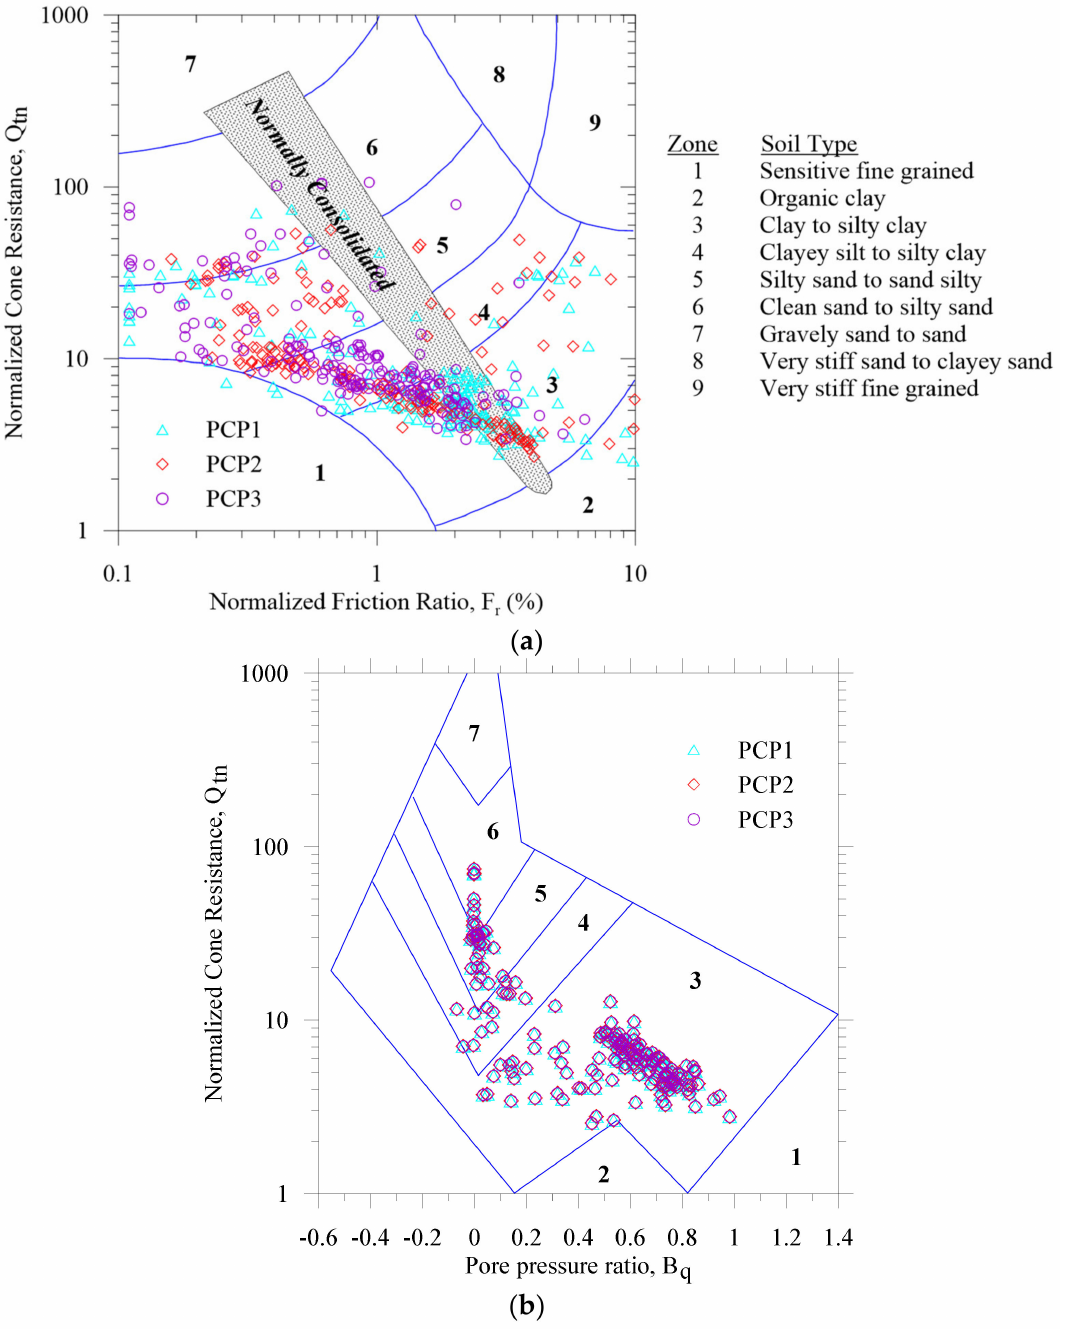
Figure 4. Robertson et al. (2009) soil classification: ( a ) Q t − F r and ( b ) Q t − B q